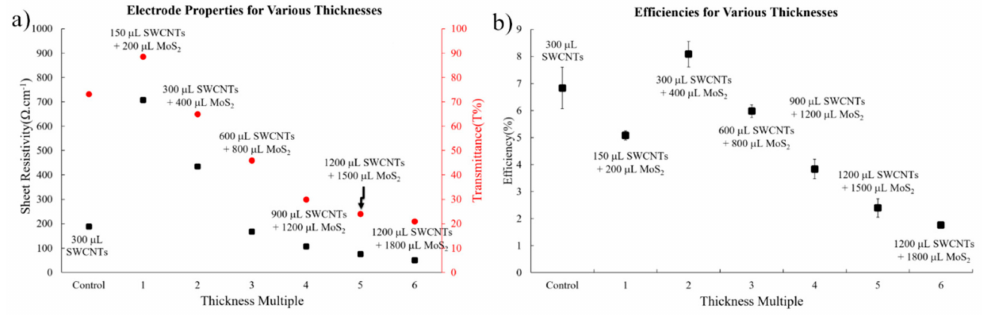
Figure 3. ( a ) Electrode properties for films of di ff erent thicknesses; ( b ) E ffi ciencies of solar cells with di ff erent thickness